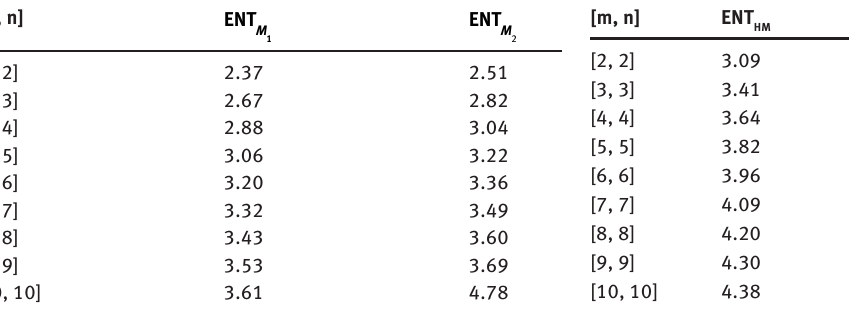
entropy for T 2 C